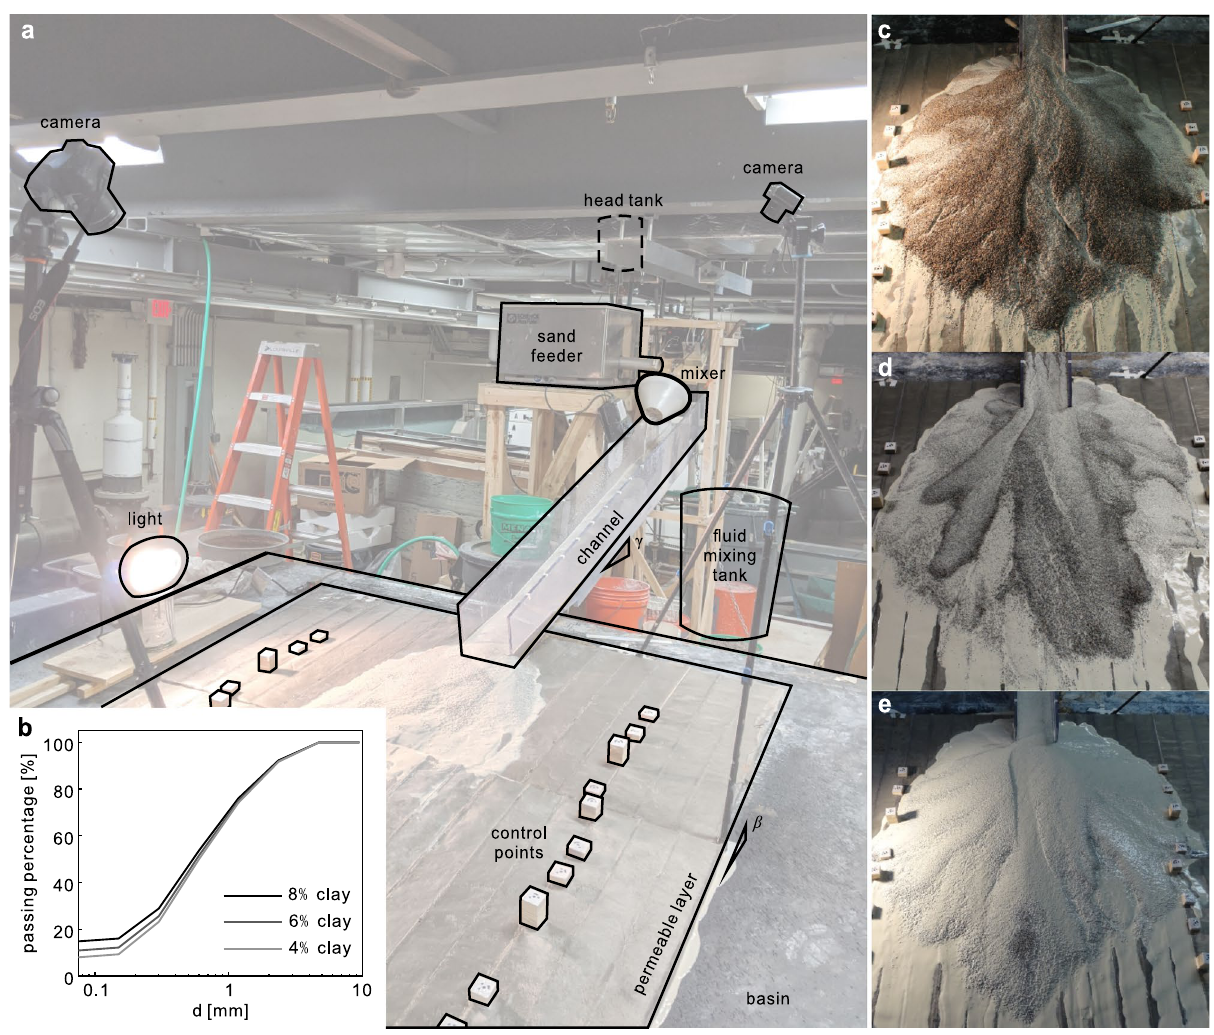
Figure 2. ( a ) Laboratory set-up and ( b ) grain size distribution of our three mixtures (data presented in Supplementary Table 5). ( c–e ) Experimental alluvial fans resulting from continuous 15-min releases with: ( c ) (sand:clay:water) = (50:4:46) by weight; ( d ) (sand:clay:water) = (52:6:42) by weight; ( e ) (sand:clay:water) = (48:8:44) by